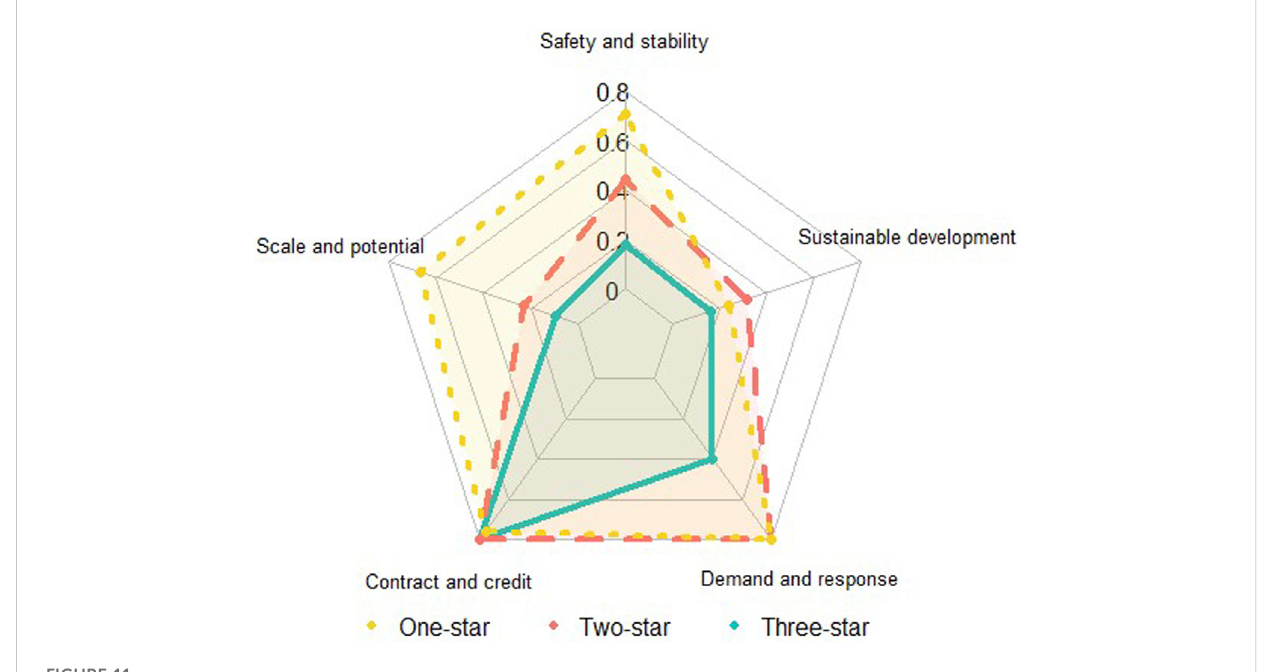
FIGURE 11 Radar chart of natural gas customer value